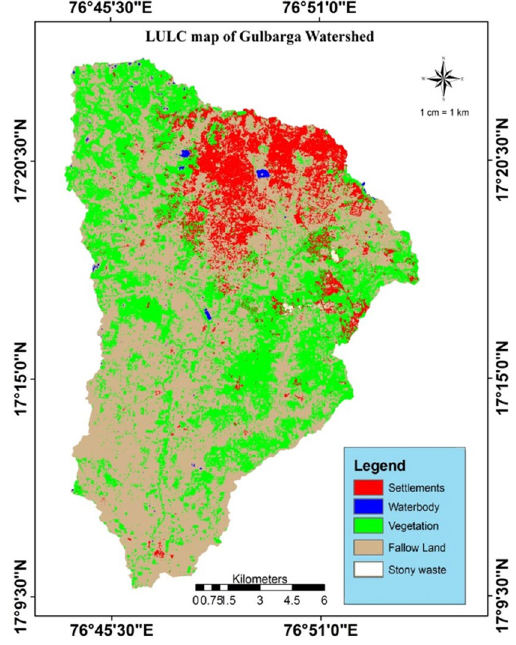
Fig. 3 Land use–land cover map Fig. 4 Digital elevation model